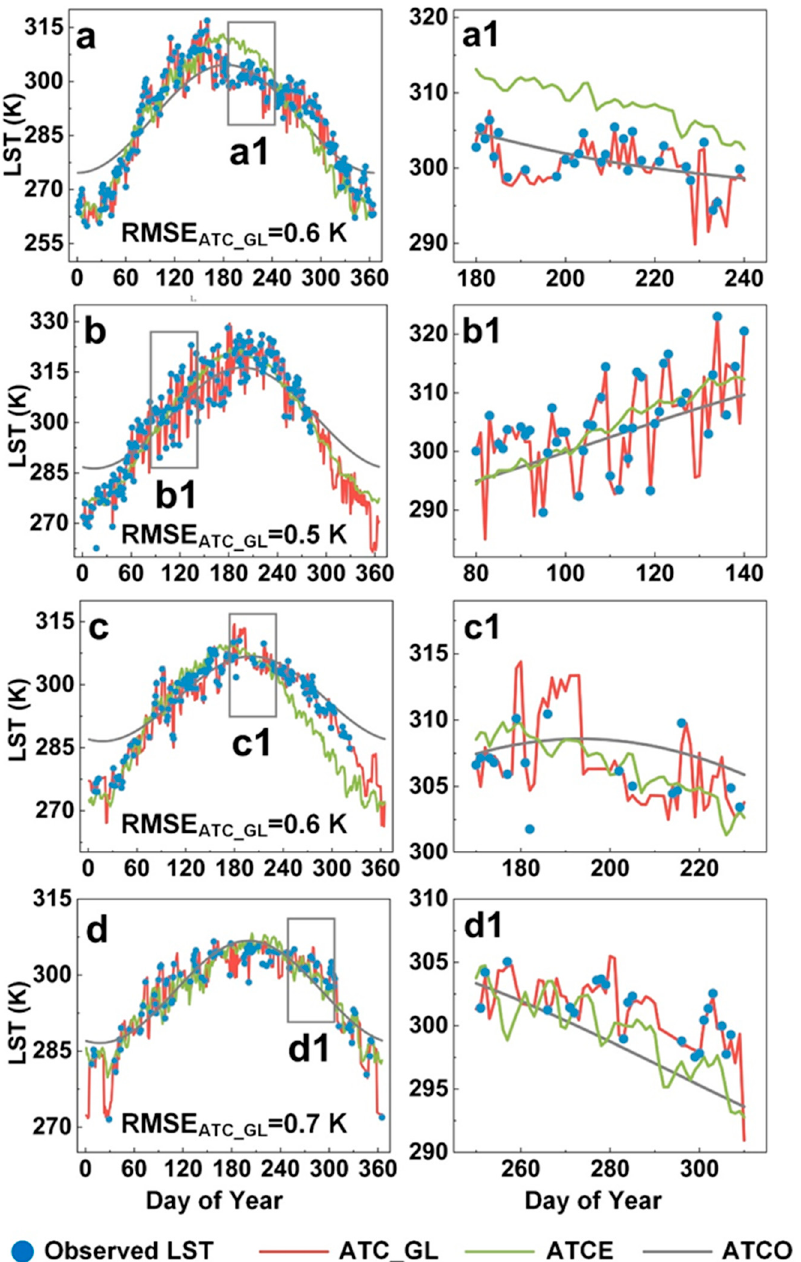
Figure 8. The performance of the ATC_GL, ATCE, and ATCO at four randomly selected pixels in Regions A–D (labelled ( a – d )). Each randomly selected pixel corresponds to a specific subfigure. Subfigures ( a1 – d1 ) are the enlarged insets of subfigures ( a – d ). Subfigures ( a1 – d1 ) are the enlarged insets of subfigures ( a – d